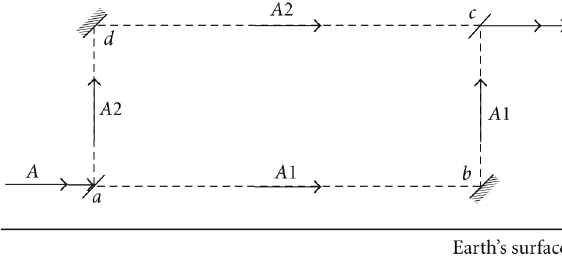
Figure 1: COW Neutron